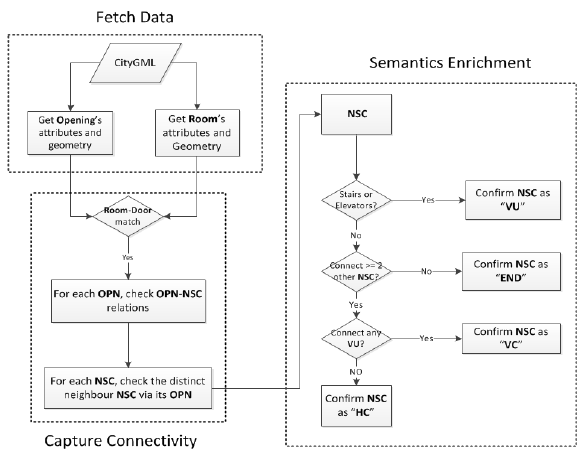
Figure 4. Flowchart on capturing connectivity and semantics enrichment